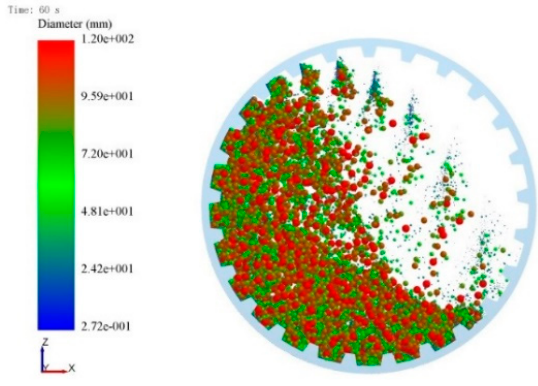
Figure 5. Mill operation process.